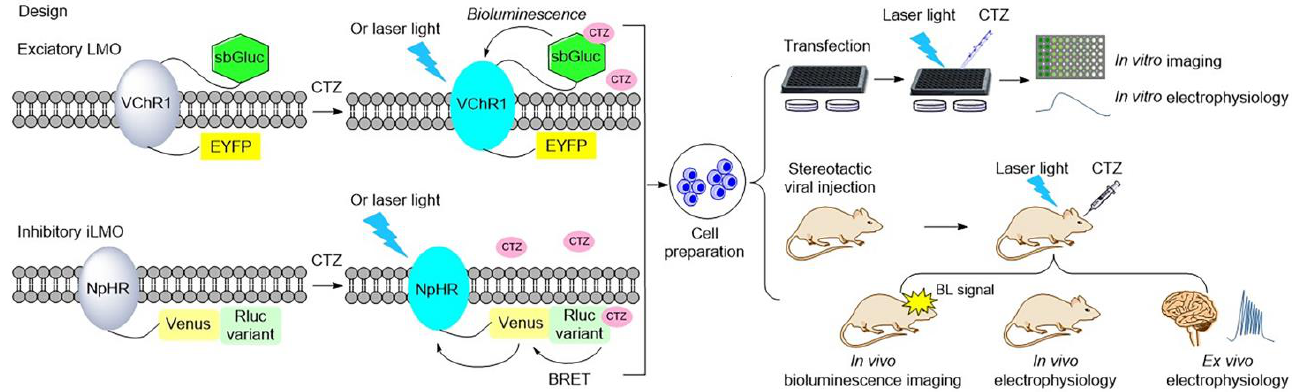
Figure 4. Illustration of typical luminopsins [17,54–56,58,59,65,87] and the general experimental procedure for studying and controlling neural activity in vitro and in vivo. Luminopsins are triggered by bioluminescence or bioluminescence resonance energy transfer (BRET) with the addition of luciferin. They can also be activated by laser light.